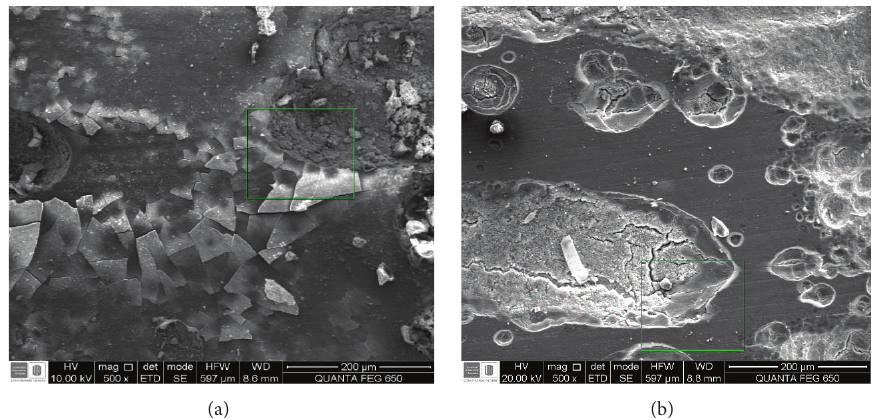
Figure 9: SEM images of AISI 4330 steel electrode after tests in a solution containing 3 wt.% NaCl and 10wt.% sand (a) 2800 rpm, pH